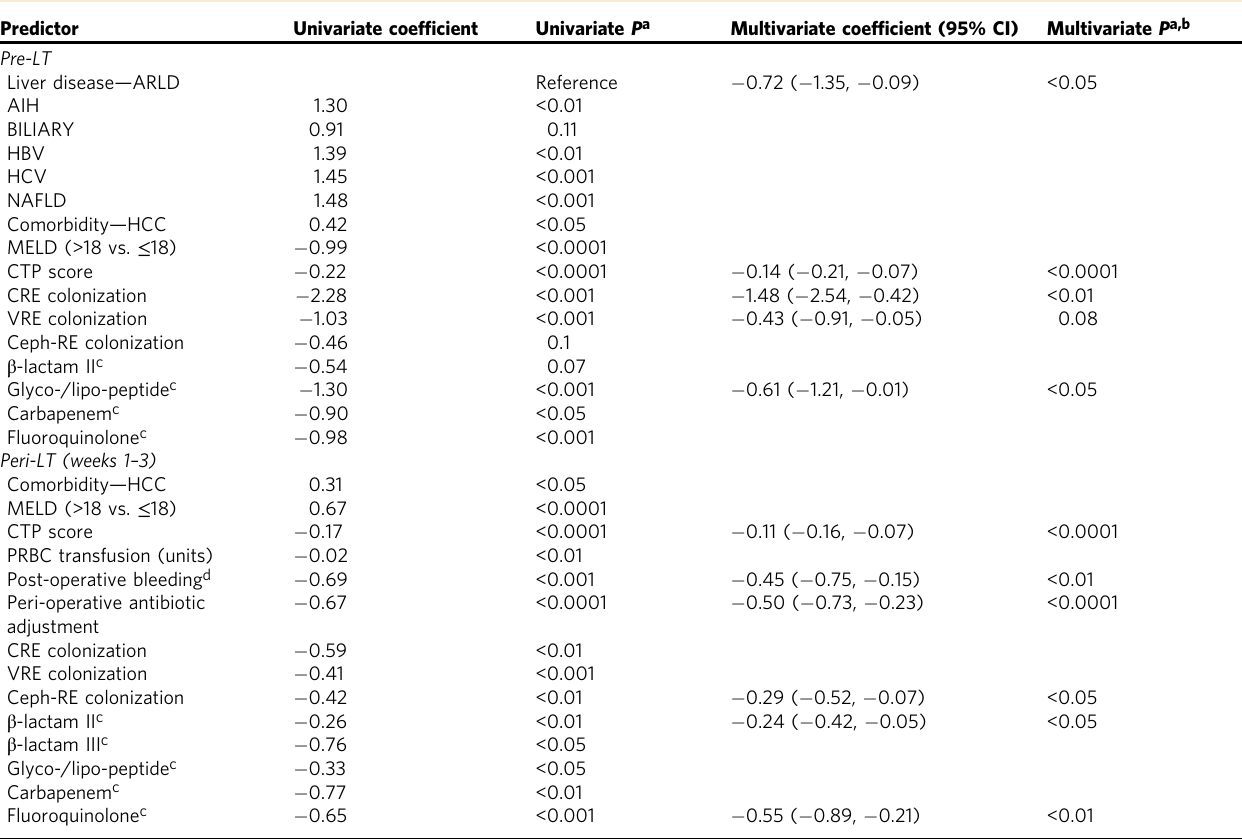
Table 2 Multivariate linear mixed-effect regression models assessing clinical and microbial predictors associated with gut Shannon α -diversity before and immediately after liver transplantation